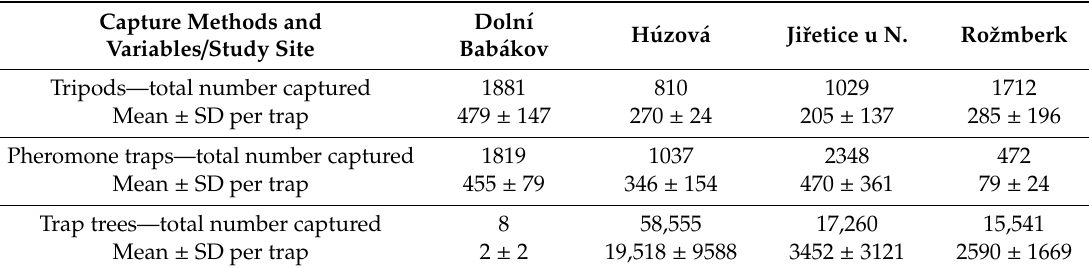
Table 8. Numbers of I. cembrae captured in baited tripod traps, pheromone traps, and trap trees in experiment 5.